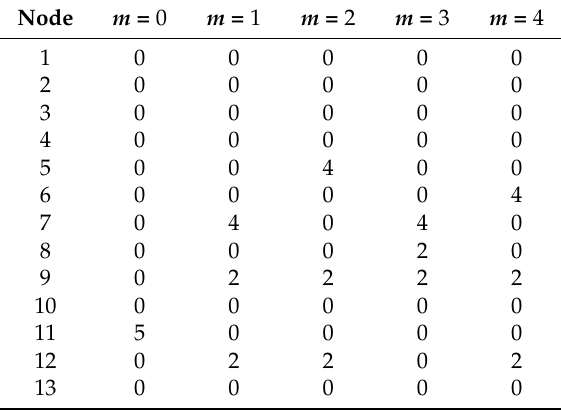
Table 10. Number of chargers at every node for various range anxiety levels.